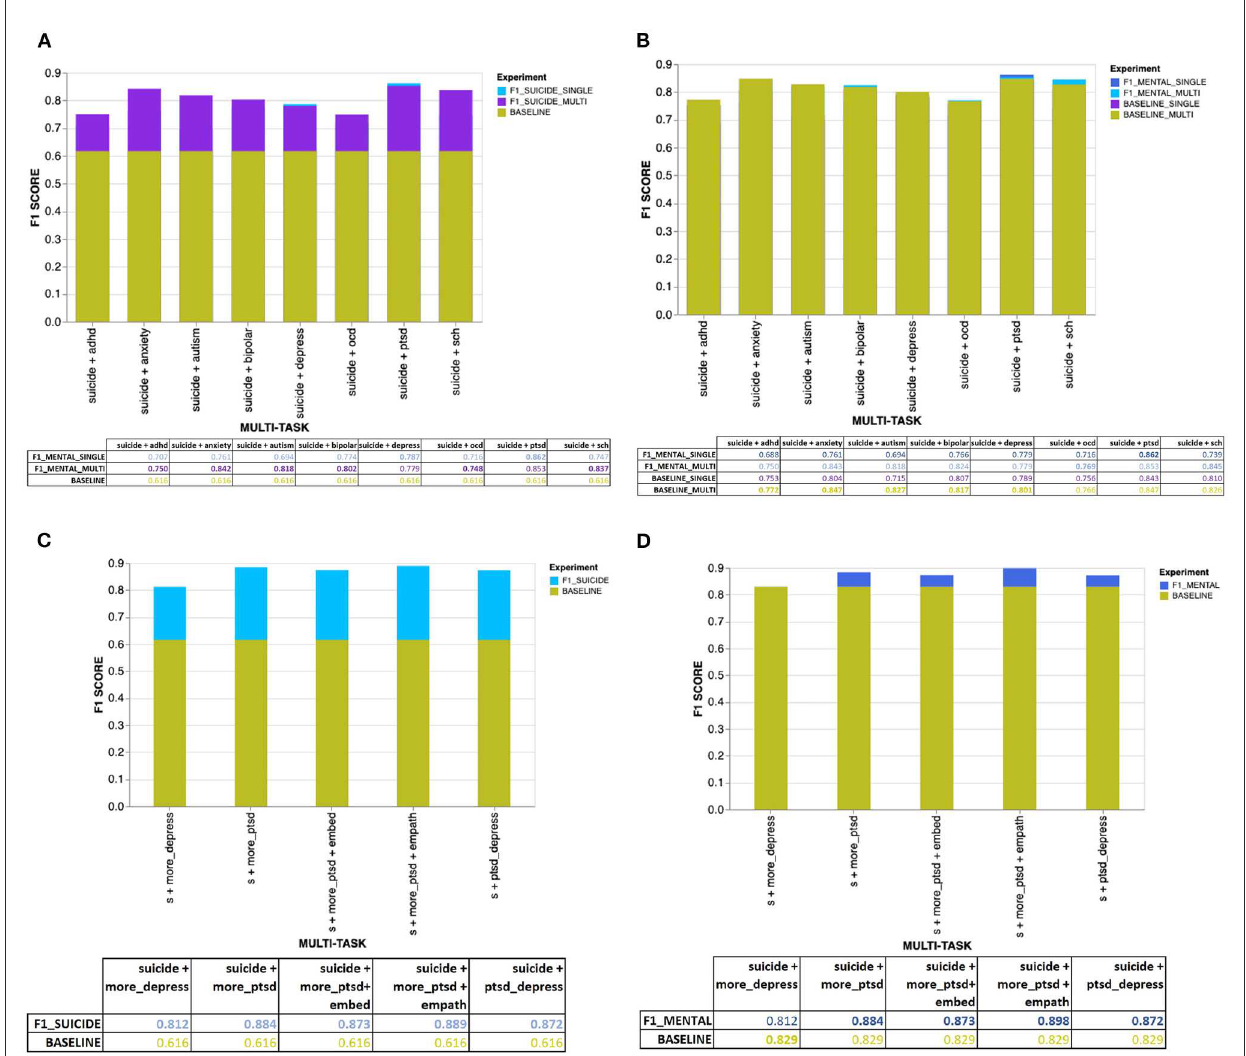
FIGURE5 (A) Overall results for the suicide ideation detection task (for users requiring urgent attention) with users diagnosed with single or multiple mental disorders. (B) Overall results for the mental illness detection task with users diagnosed with single or multiple mental disorders. (C) Overall results